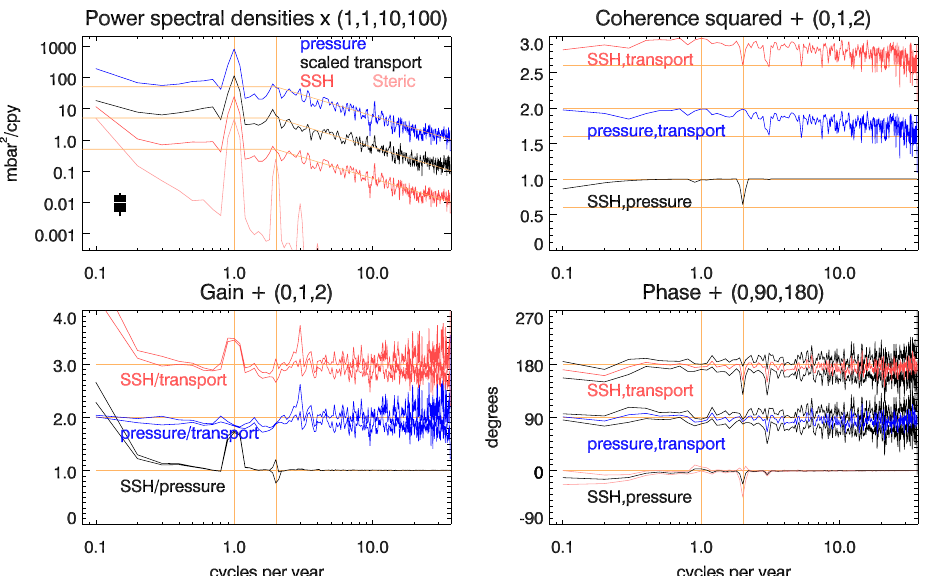
Fig. 4. Spectra and cross-spectral analyses based on time series from the 1 / 4 ◦ model. Top left: power spectra for depth-averaged southern boundary pressure (blue), the analogous sea level (sub-surface pressure) time series (red), the difference sub-surface minus bottom pressure (pink), and Drake Passage transport divided by − 3.69Svmbar − 1 . Other panels show the squared coherence, gain, and phase lag between pairs of these time series as described in the legends. Orange lines are for guidance and show the offsets applied to the different curves, as well as the annual and semiannual frequencies and, in the case of squared coherence, the value representing significance at the 95% level. The phase plots include 2 σ error bounds, and the power spectra plot includes a scale bar for the uncertainty (95% and 99%) to be applied at each individual frequency (band averages have smaller errors). Two versions of the gain are shown, representing ratios a/b derived from regressions of a on b , and from b on a , where a and b are the two time series. When both time series contain noise, the true relationship between them tends to lie between these two